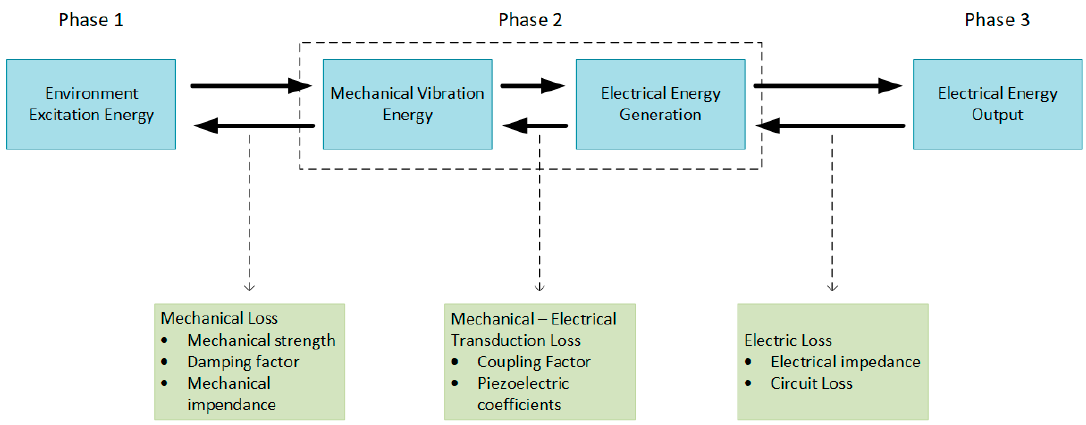
Figure 3. The three phases associated with piezoelectric energy harvesting.